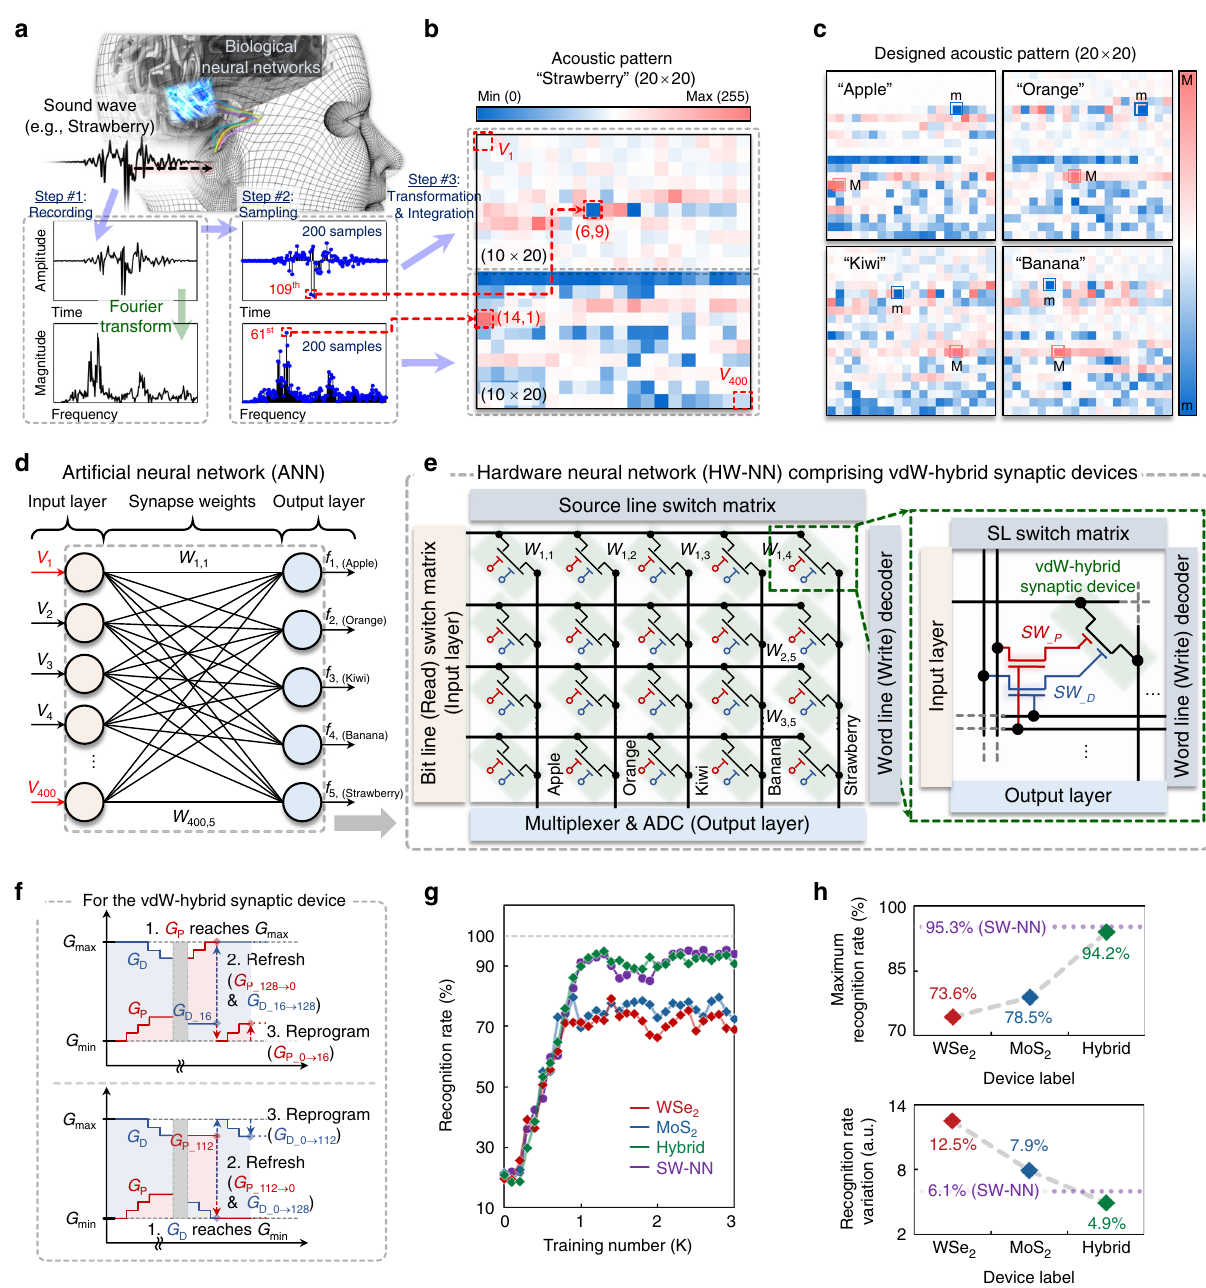
Fig. 4 Acoustic pattern recognition task. a Design procedure of acoustic pattern (from recording, through transforming, to integrating). b Designed 20 × 20 acoustic pattern, where each pixel has a grayscale value in the range between 0 and 255. c Designed acoustic pattern. d Single-layer arti fi cial neural network (ANN) consisting of input neurons, synapses, and output neurons. e The hardware neural network (HW-NN) comprising the vdW-hybrid synaptic device for the conceptual neural networks. f Weight update method based on operations of “ refresh ” and “ reprogram ” for the vdW-hybrid synaptic device. g Acoustic pattern recognition rates based on three ANNs comprising WSe 2 , MoS 2 , or hybrid synaptic devices, and comparison with the rate based on SW-NN. h Extracted maximum recognition rates and corresponding recognition tasks. Details on this HW-NN are described in Supplementary Fig. 25.